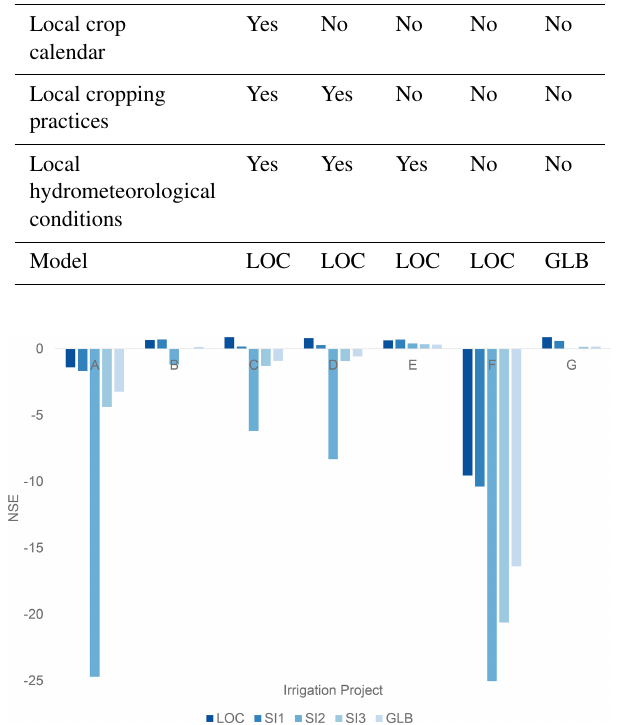
Figure D1. The results of sensitivity analysis. See Table D1 for simulation runs. The NSE for irrigation project F (SI2) is − 98 . 4.